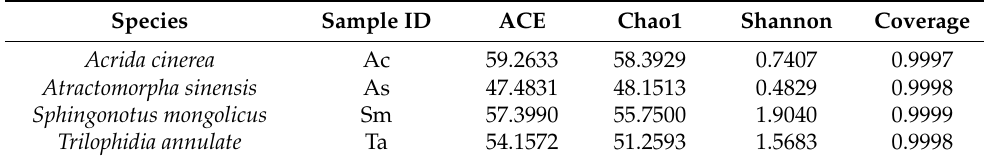
Table 3. The average value of the Alpha diversity index of each